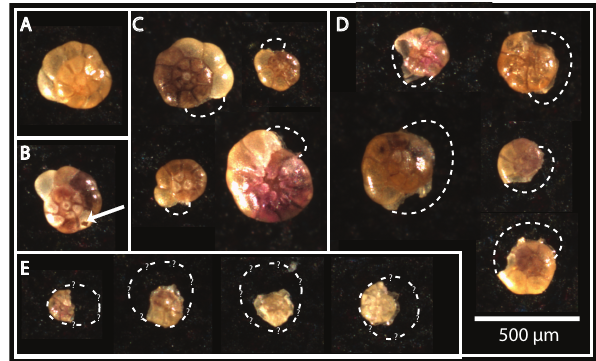
Fig. 1. Examples of the different levels of damaged A. tepida sub- mitted to ultrasonication for 5s. Dashed lines give a reconstruction of the damaged parts of the test. (A) Test of A. tepida with an intact test. (B) Test with a hole in the middle of a chamber. (C) Individuals with the last chamber missing. (D) Individuals with several external chambers missing. (E) Individuals with only the inner chambers in- tact, making it difficult to reconstruct the original shape and size of the